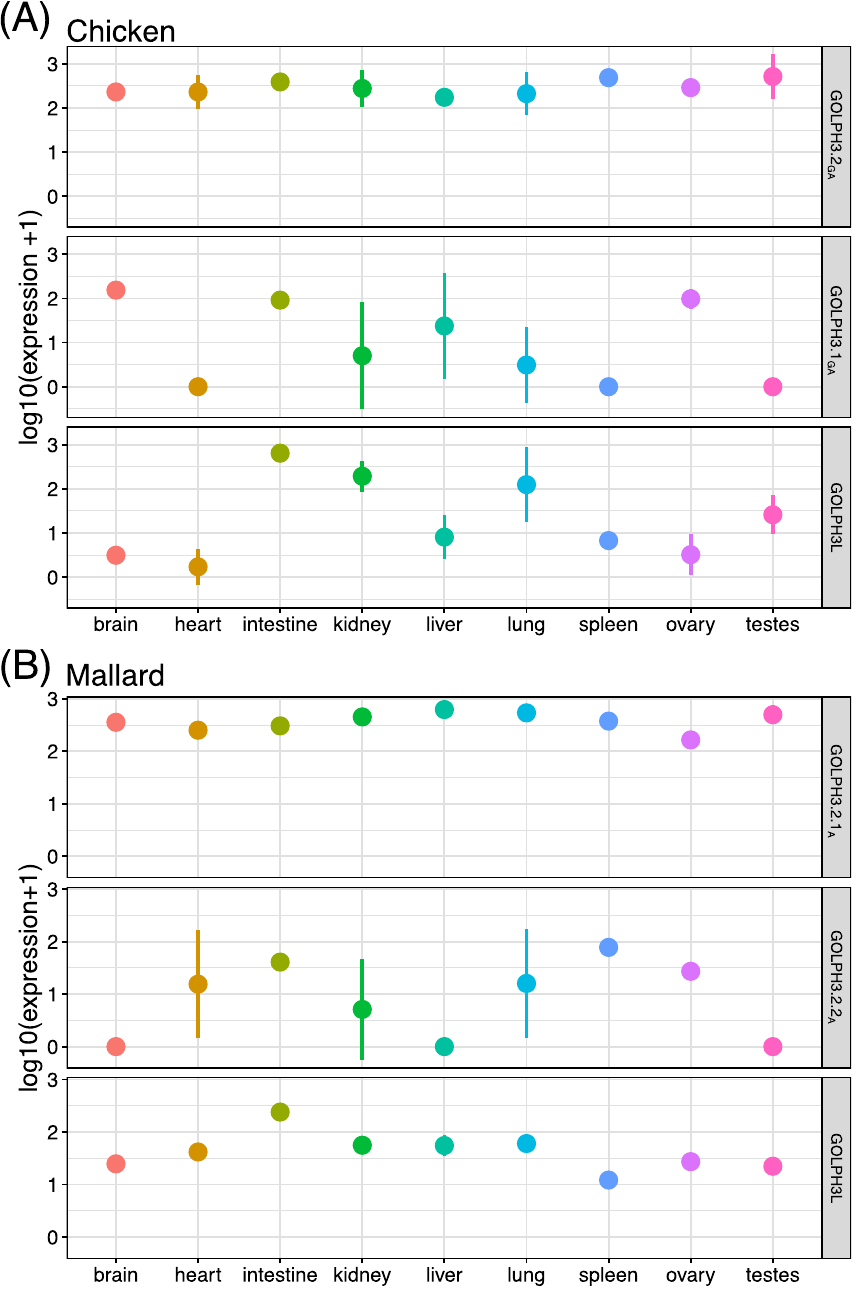
Figure 9. Transcript abundance measurements of GOLPH3 paralogs across a panel of nine tissues in ( A ) chicken ( Gallus gallus ) and ( B ) mallard ( Anas platyrhynchos ). The mean and standard deviation are plotted for three replicates per tissue. In many cases the standard deviation was smaller than the size of the circle representing the mean and appears